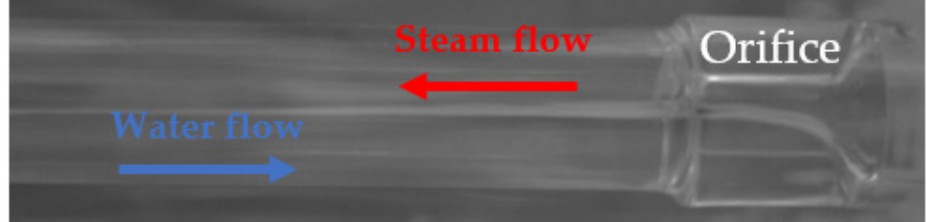
Figure 8. Countercurrent flow in the orifice.